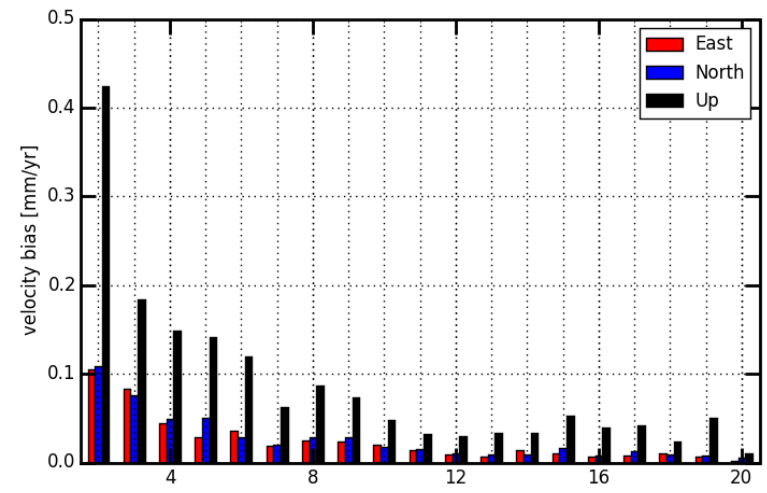
Figure 11. Mean of absolute velocity bias between solution cova_tr_s0 and cova_tr_s2.